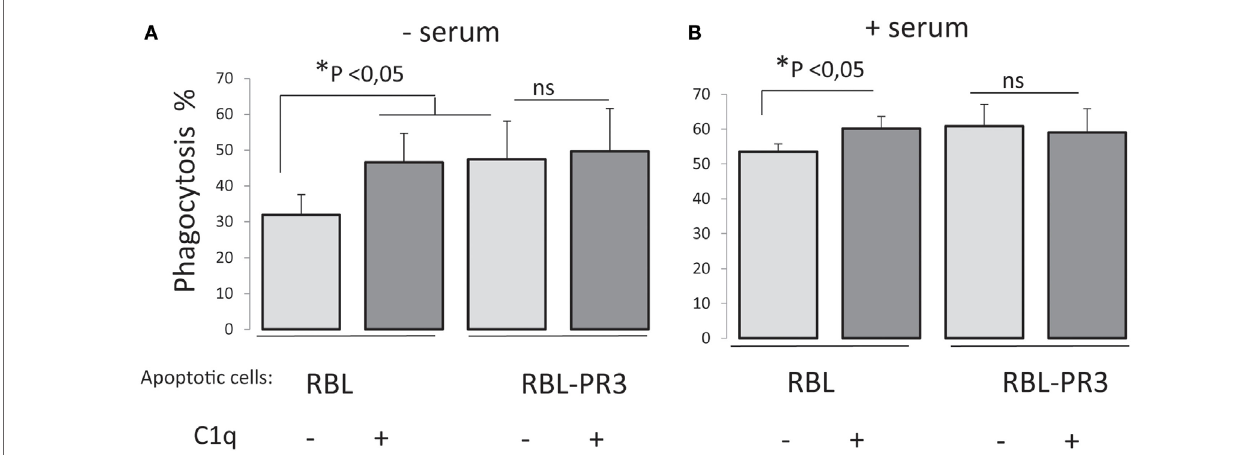
FigUre 4 | Surface proteinase 3 (PR3) exposure supresses C1q enhancement of apoptotic cell phagocytosis. Late apoptotic rat basophilic leukemia (RBL) cells labeled with CFSE, opsonized or not with C1q (80 µg/ml), were incubated with PMA-treated THP1 cells labeled with PKH26 dye, 1 h at 37°C in absence (a) or in presence of serum (B) . Phagocytosis is expressed as the percentage of the double-labeled cells in the macrophage population (i.e., PKH26 and CFSE labeled cells). Data are the mean ± SD of independent experiments. *Significance was tested using non-parametric two tail Wilcoxon signed-rank test for paired samples, n = 5 (without serum) and n = 4 (with